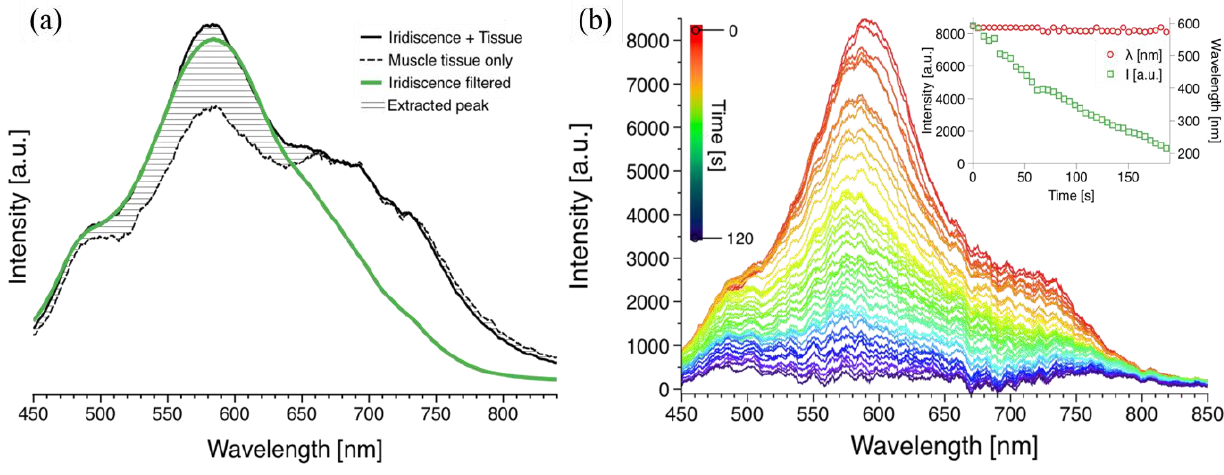
Figure 2. Diffraction spectra of the muscle tissues for static and real-time measurements ( a ) continuous line shows the raw spectral measurement at the angle of incidence with maximum diffraction intensity; dashed line corresponds to the colour of the muscle tissue (absorption); and green line represents the filtered diffraction spectrum. ( b ) Real-time measurement of diffraction of the diffraction grating during drying. Each plot was recorded every 3 s; the top spectrum (red) shows the diffraction intensity at t = 0 s, and the bottom spectrum (violet) represents the diffraction intensity at t = ~2 min. The inset represents the steady diffraction wavelength and the decreasing intensity of the diffraction